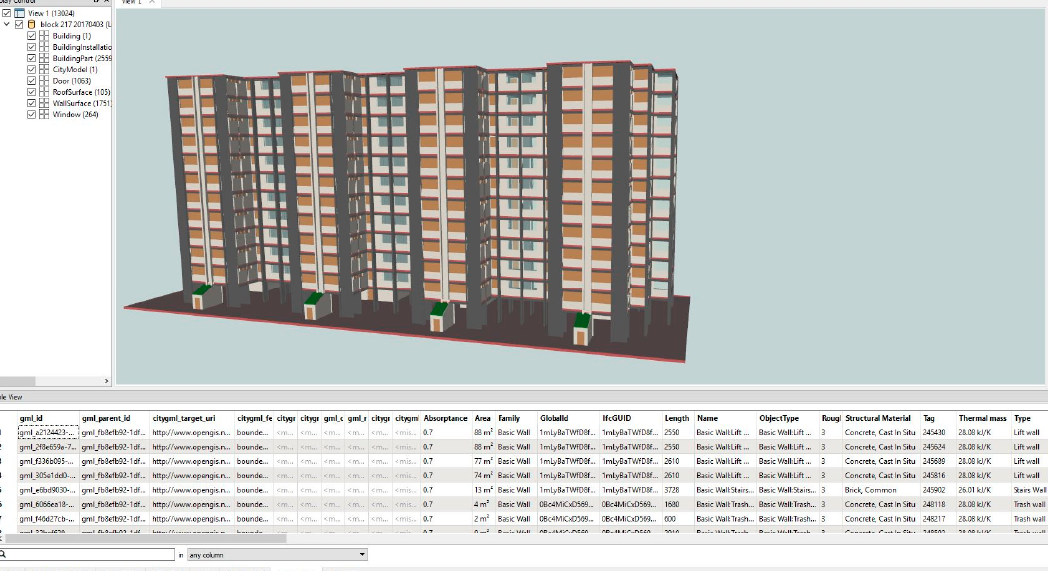
Figure 10. LOD3 CityGML model.